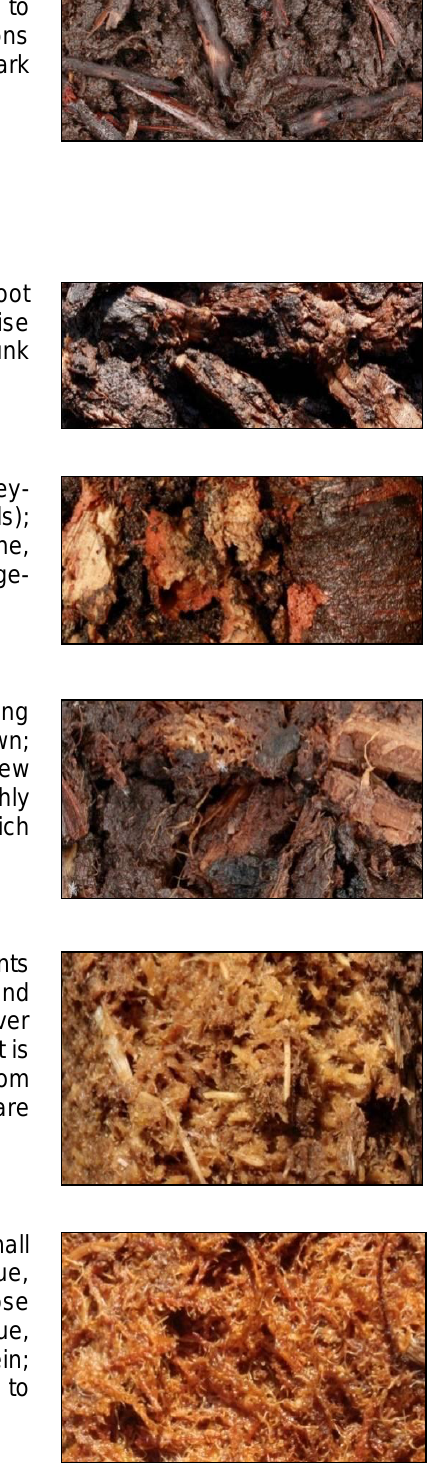
Shiny (metallic), vibrant gold-brown, bronze or red-brown, small moss plants; stems: relatively robust, about 1 mm thick, opaque, unbranched or only slightly branched, occasionally with squarrose appearance and often fully foliated; leaves: shiny, opaque, polymorphic (e.g. acute-lanceolate, ovate, falcate), with leaf vein; when more highly decomposed, colour varies from dark brown to black and moss remains are more difficult to